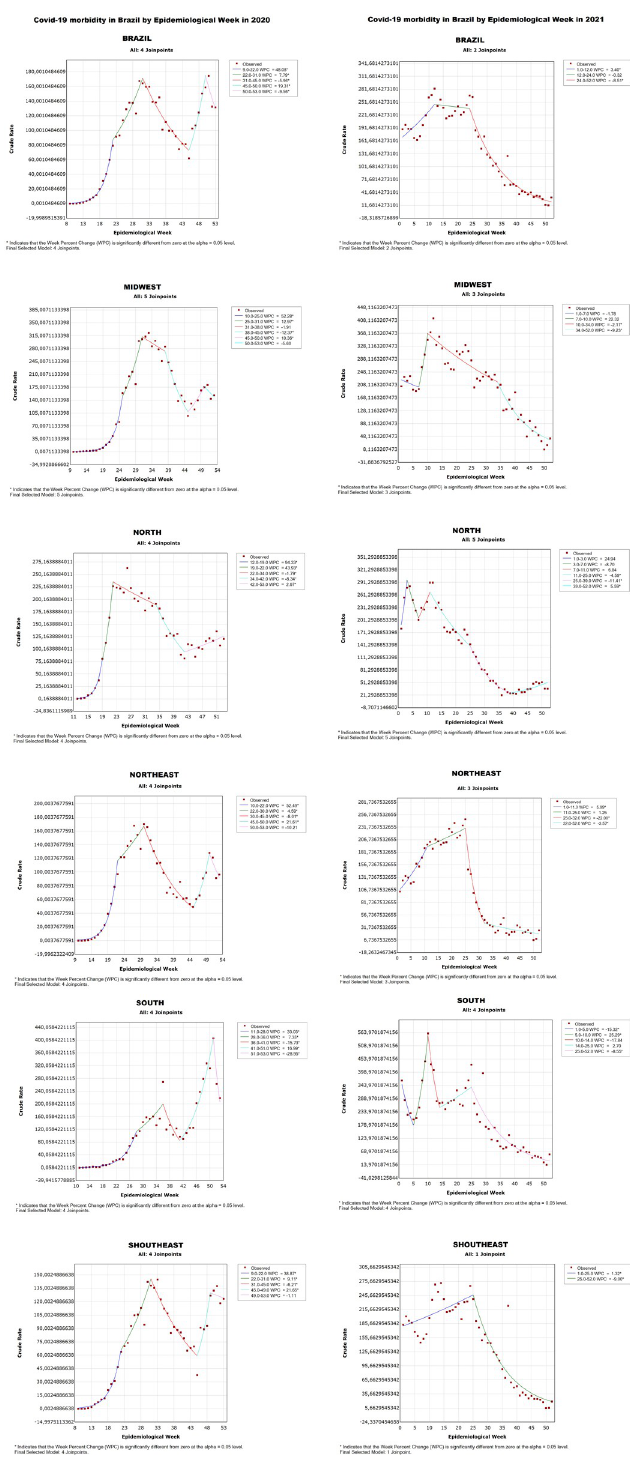
Fig 2. COVID-19 morbidity rate in Brazil and its regions from 2020 to 2021. Brazil, 2022.